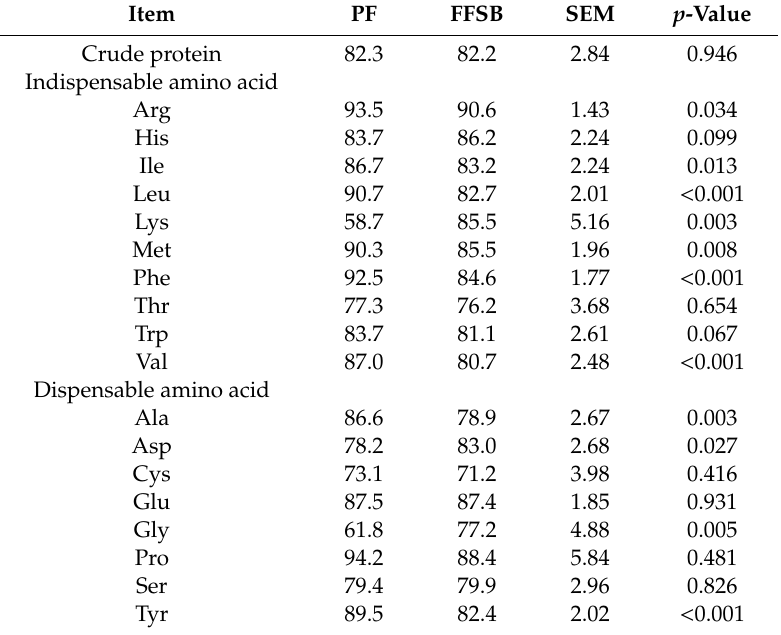
Table 8. Standardized ileal digestibility (%) of crude protein and amino acids for experiment 2 1,2